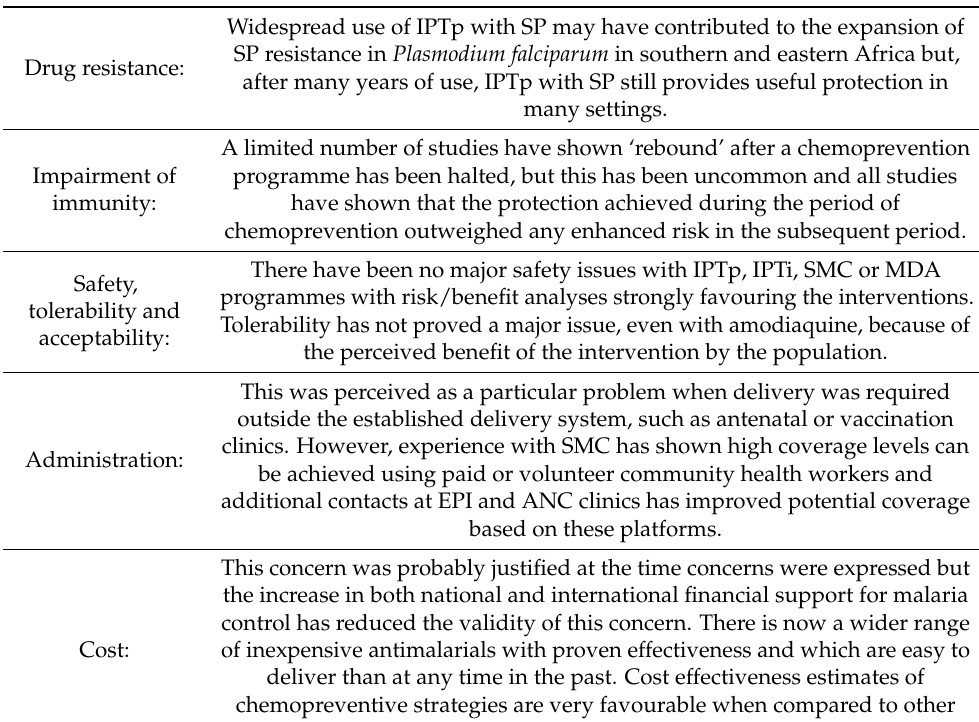
Table 2. Validity of the initial concerns over the use of chemoprevention in the resident population of malaria endemic